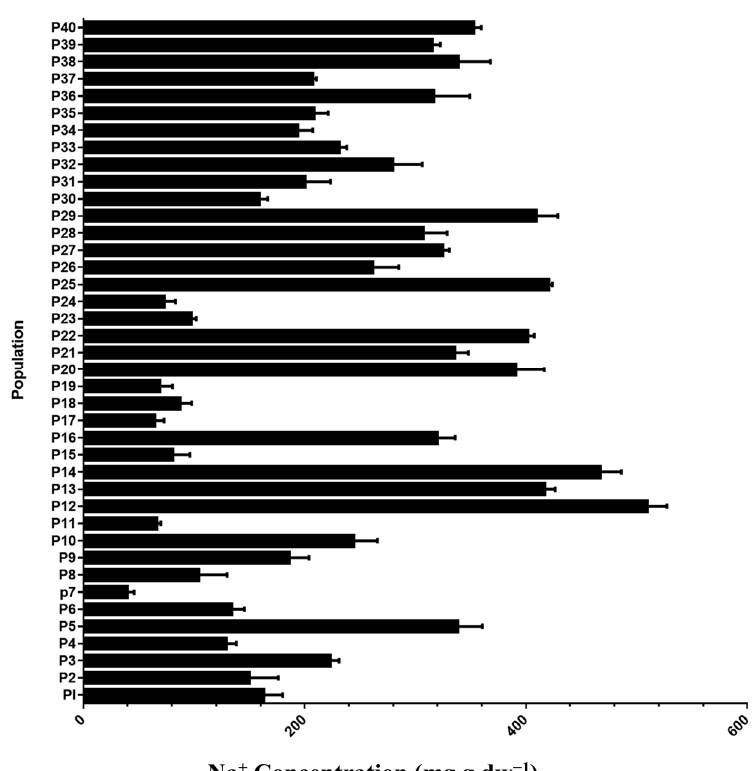
Figure 1. Na + concentration in leaves of 40 Ae. tauschii populations under salinity stress conditions (300 mM NaCl). Values are means, and bars indicate standard deviation (SD). (300 mM NaCl). Values are means, and bars indicate standard deviation Table 3. The correlation coefficient between plant dry weight biomass, plant height, Na + , K + , and K + /Na + in Ae. tauschii populations (40) under salinity stress condition (200 mM NaCl).